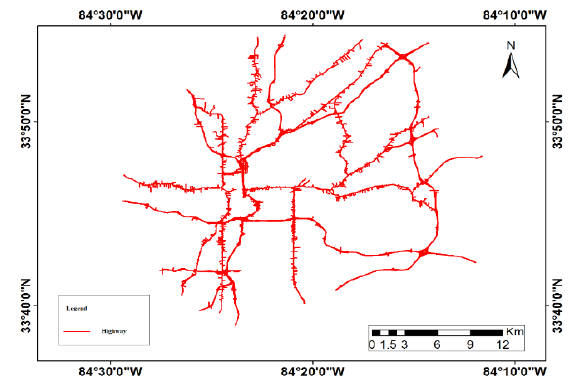
Figure 5. Position of the study area